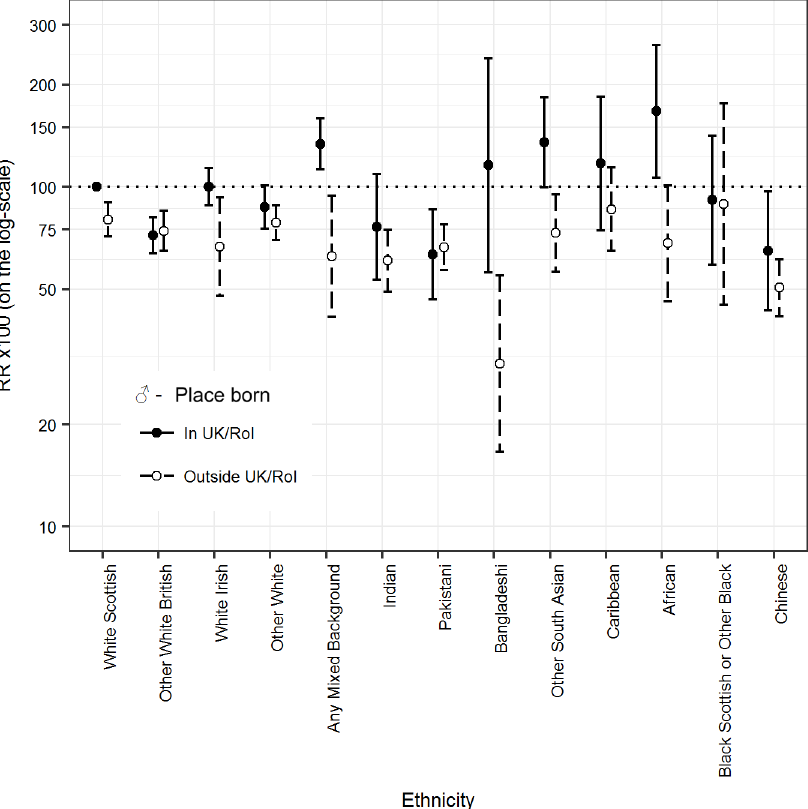
Fig 5. Age-adjusted RRs (bars show 95% CIs) for all-cause mortality by ethnicity and country of birth (UK/RoI born or not) in males. RR, rate ratio; UK/RoI, United Kingdom or Republic of Ireland.